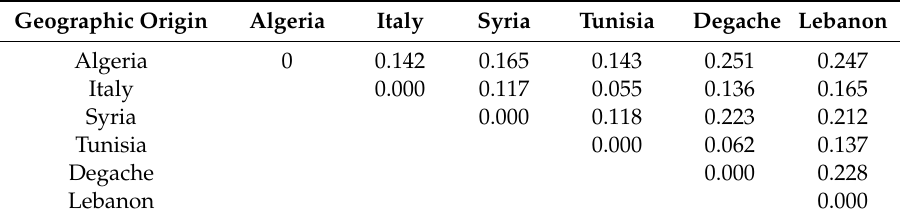
Table 4. Genetic di ff erentiation (Pairwise population Fst) between the six groups of genotypes of Table 4. Genetic differentiation (Pairwise population Fst) between the six groups of genotypes of di ff erent geographic origin. different geographic origin.